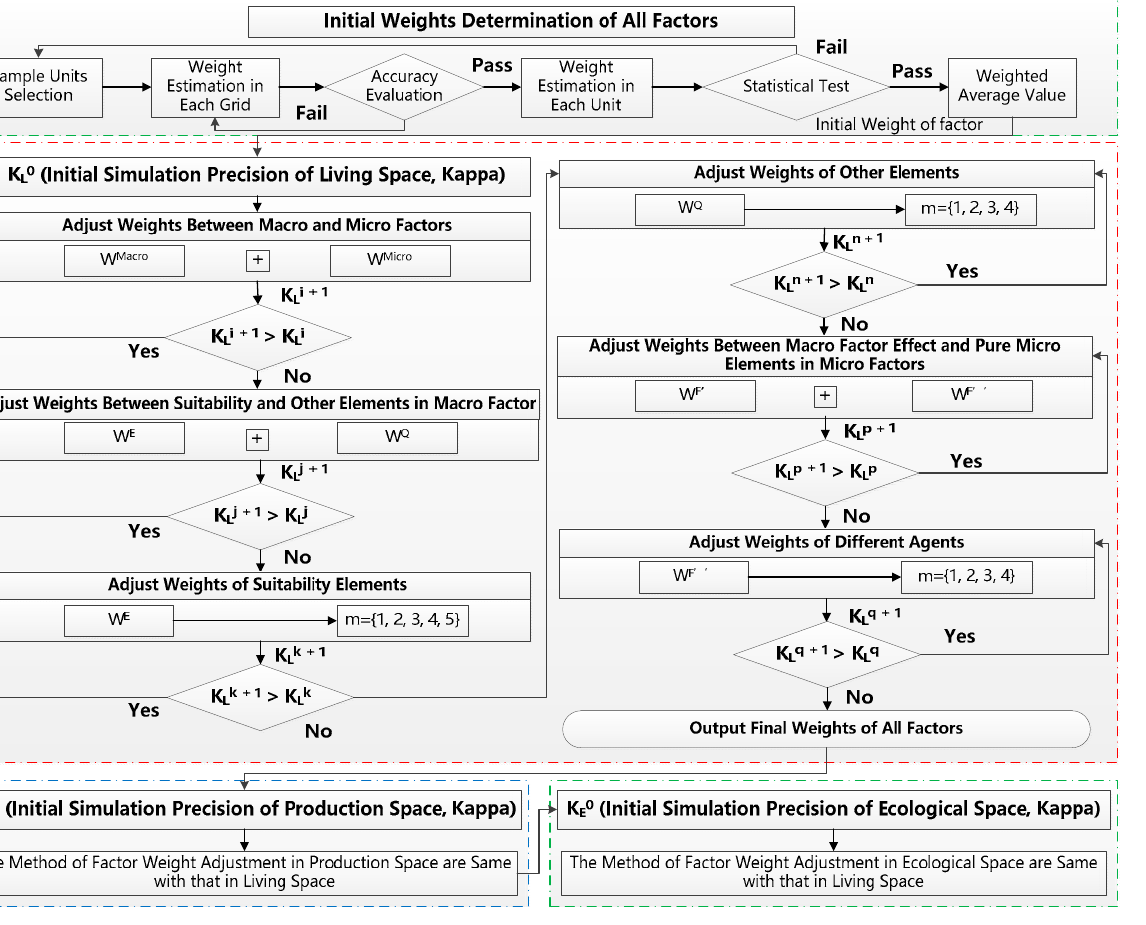
Figure 3. The data processing flow of factor weight determination using statistical analysis and best-fit method. The meanings of symbols are same with those in Equations (1)–(9).